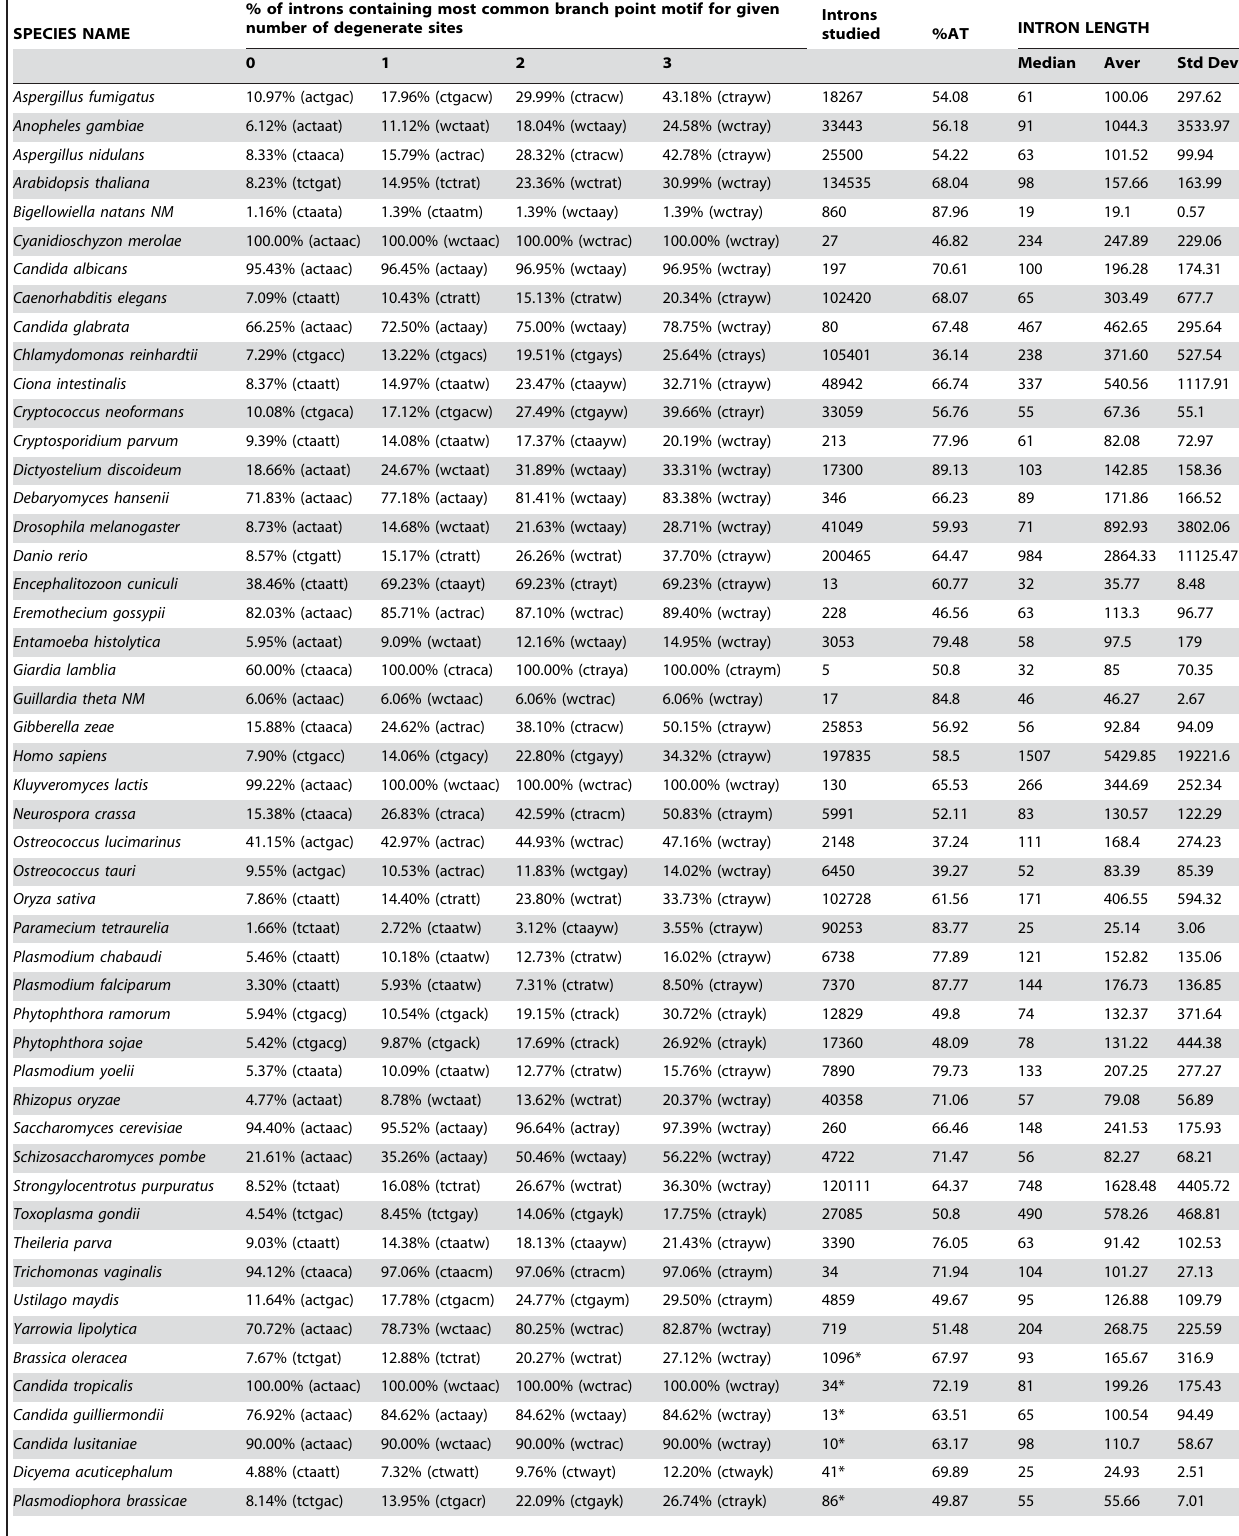
Table 2. Intron features for the 50 eukaryotic species included in this